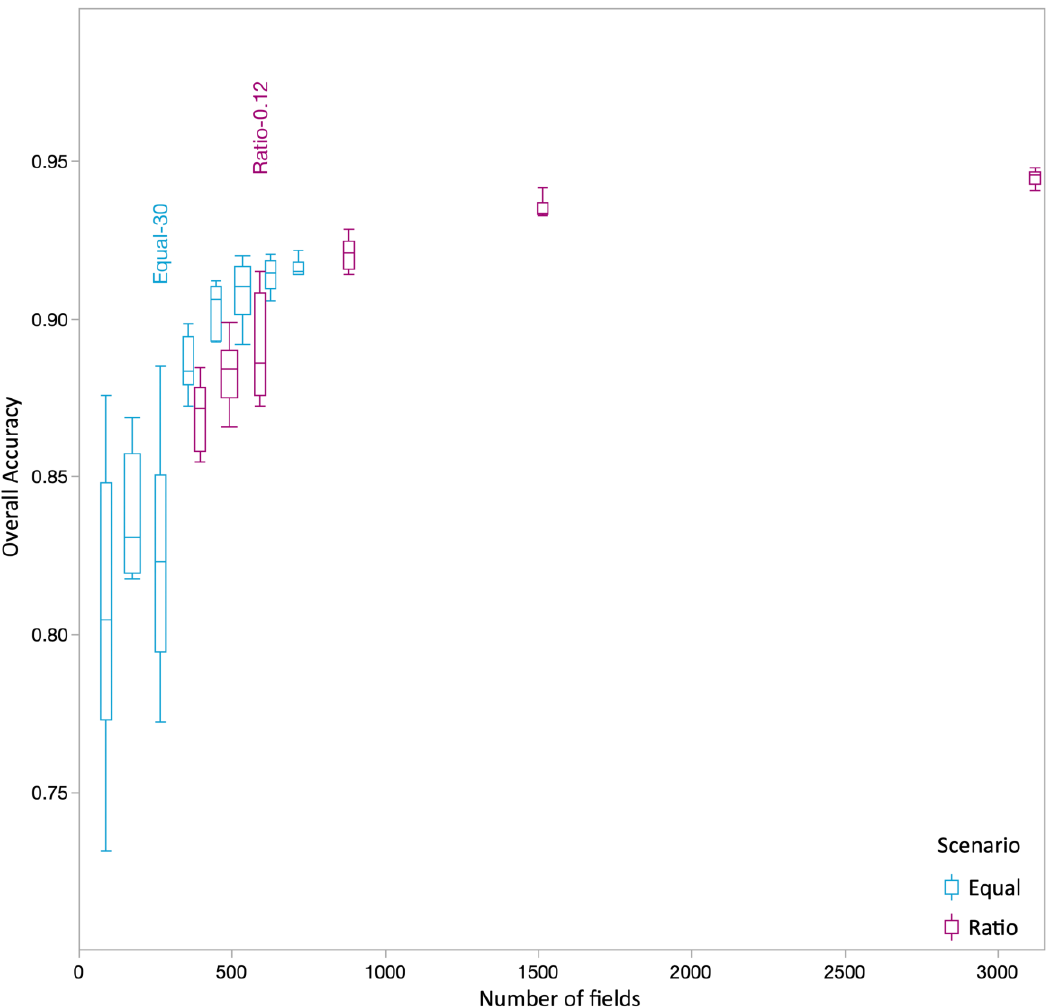
Figure 4. Overall accuracy (OA) as a function of the number of fields used for training the classification algorithm. Data illustrate two scenarios: For Equal, each crop type was represented with the same number of fields. For Ratio, fields were represented proportionately. Box plots indicate OAs resulting from 6 random selections of training data.